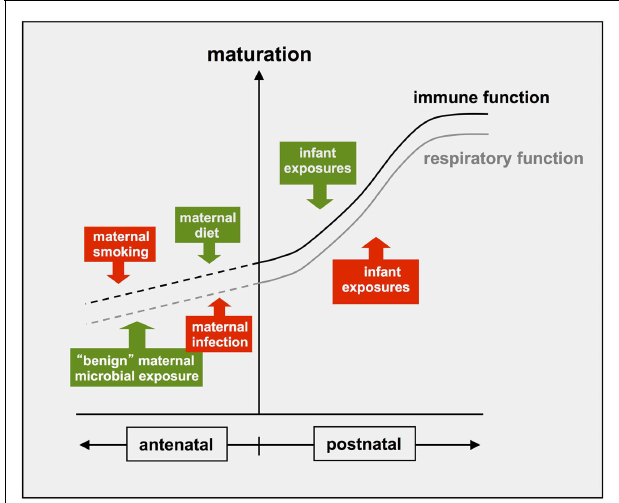
FIGURE 2 |Antenatal and postnatal factors influencing development if immune and respiratory functions . Recent evidence indicates that the postnatal maturation of both respiratory and immune functions can be influenced by positive (green) and negative (red) environmental influences, which can exert their effects after birth and/or